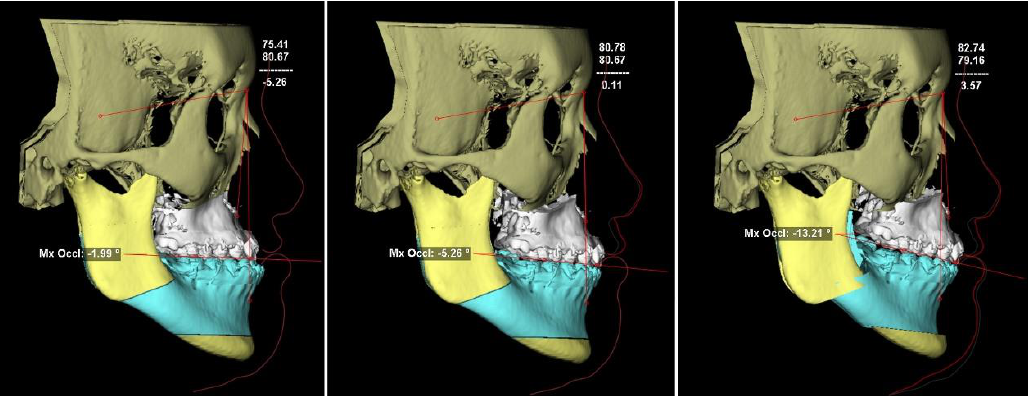
Figure 3. A case in the regular advancement design showed that the jaw relationship was improved by the clockwise rotation of the maxillomandibular complex. ( Left ) Preoperative image showing that ANB was −5.26°. ( Middle ) In one-jaw surgical simulation, the maxilla was advanced 4.63 mm following Le Fort I osteotomy. The skeletal class III jaw relationship was not fully corrected with the ANB angle of 0.11°. ( Right ) A skeletal class I jaw relationship with an ANB angle of 3.57° was achieved following two-jaw surgery with the clockwise rotation of the maxillomandibular complex.